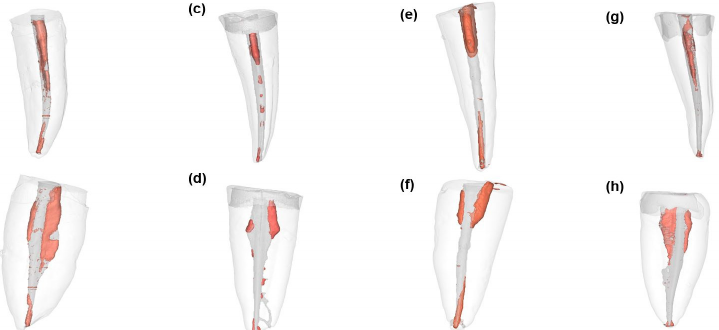
Figure 2. µ Ct images of the samples after retreatment procedures. ( a , b ) G1: D-Race files; ( c , d ) G2: D-Race and XP–Endo Finisher R; ( e , f ) G3: ProTaper Universal Retreatment; ( g , h ) G4: ProTaper Universal Retreatment and XP–Endo Finisher R file. Table 1. Time required to re ‐ establish the working length in the different groups. Different